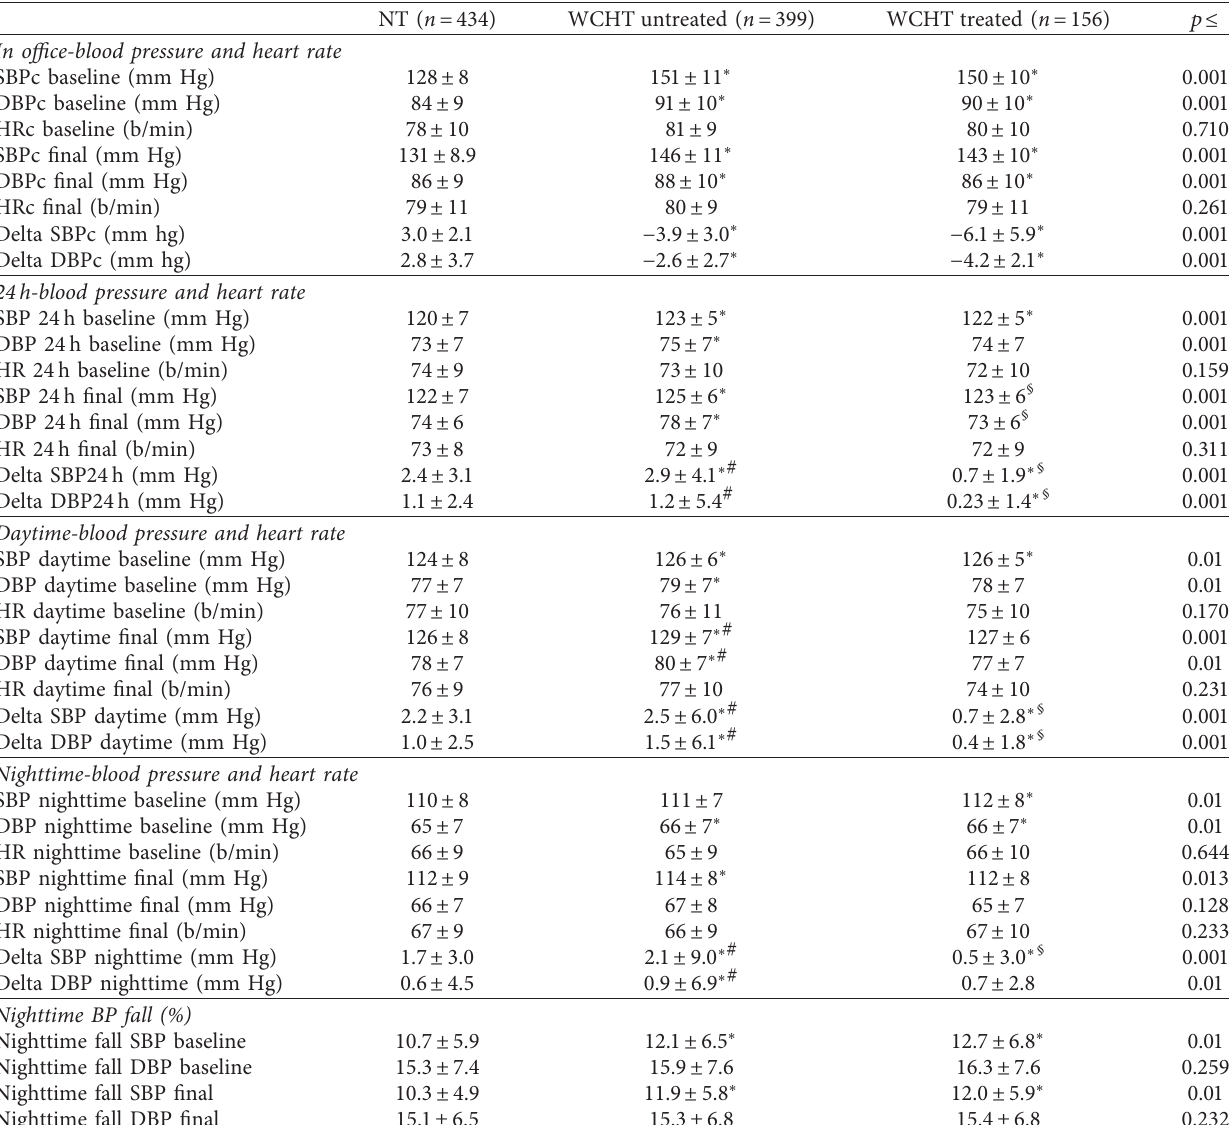
Table 2: Blood pressure